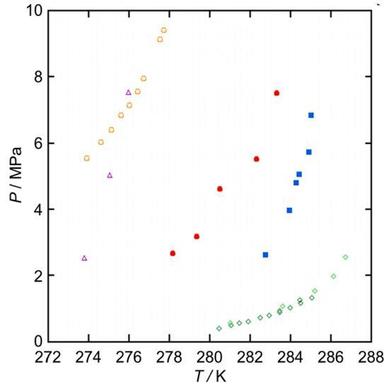
Phase equilibrium conditions of hydrates formed in (H2 + CO2) gas + THP + water system and those of hydrates related to THP, H2, and CO2. , H2 + CO2 + water system (H2:CO2 = 0.7:0.3) ;, H2 + THP + water system ;, (H2 + CO2) gas + THP + water system around H2:CO2 = 0.9:0.1 (This study); , (H2 + CO2) gas + THP + water system around H2:CO2 = 0.7:0.3 (This study); , CO2 + THP + water system ;, CO2 + THP + water system